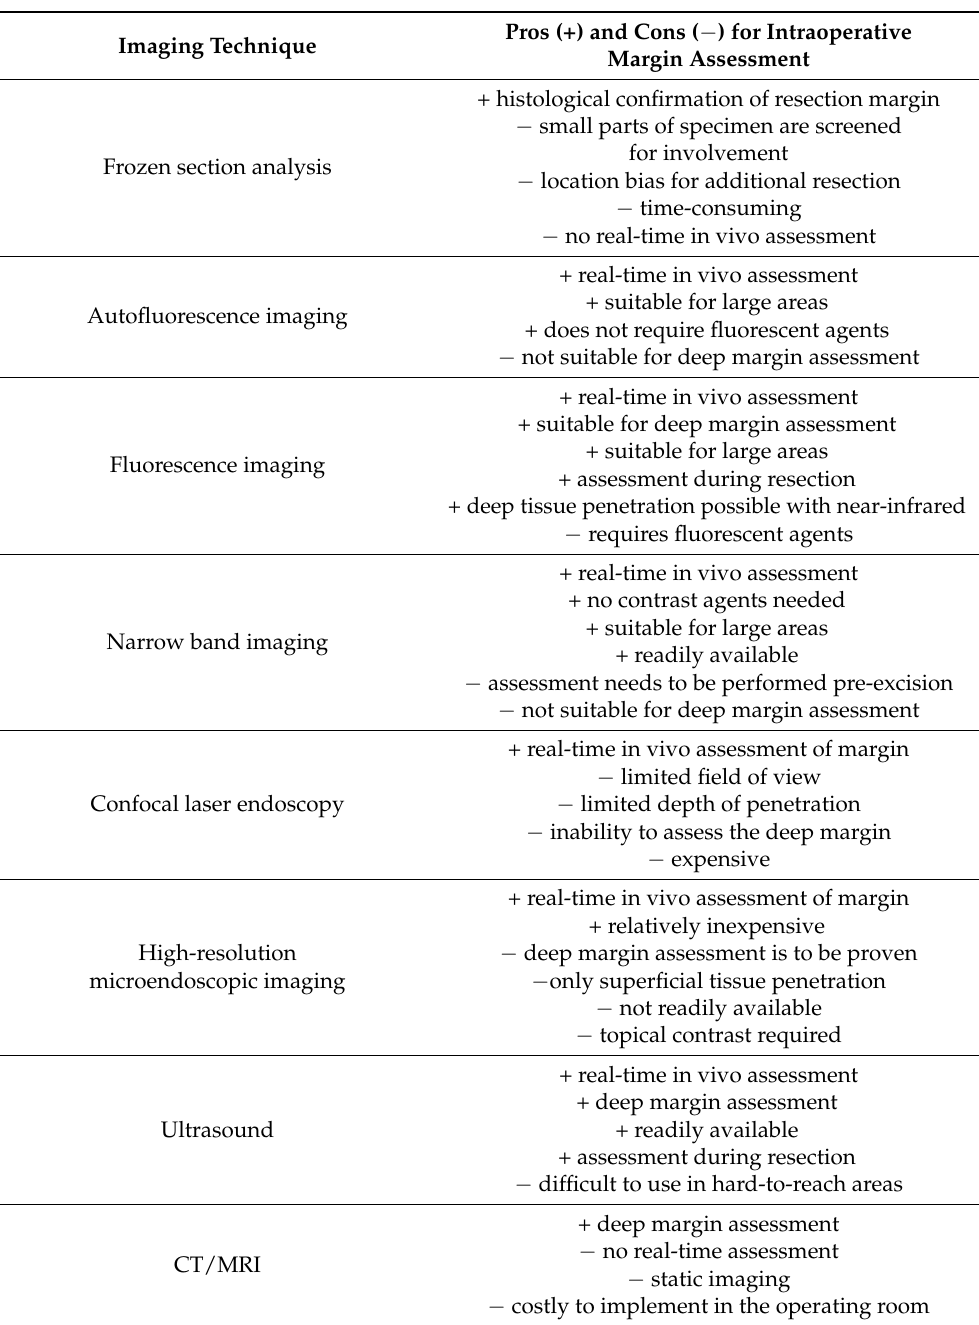
Table 4. Clinical usability of all imaging techniques for intraoperative margin assessment in oropha- ryngeal squamous cell